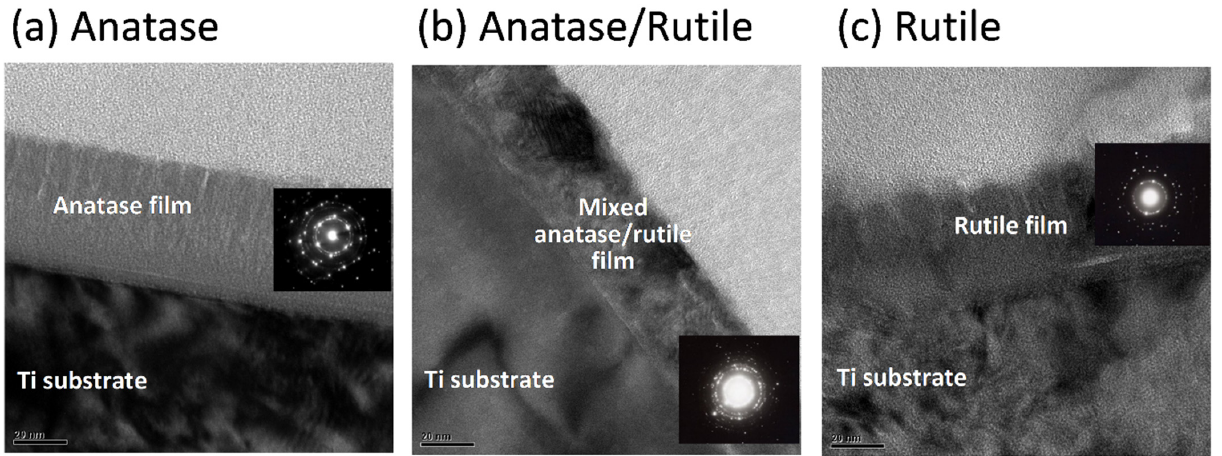
Figure 3. Crystal phase structure of TiO 2 thin films on different test Ti specimens, analyzed via TEM. The thickness of the oxide layer in the form of anatase phase, rutile phase, and a mixture of two phases was roughly 45 nm.